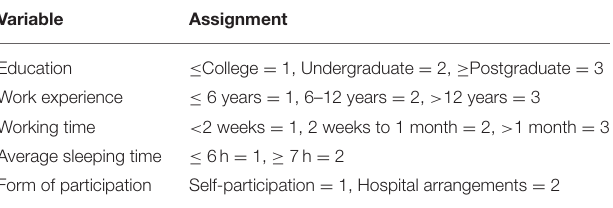
TABLE 4 | Variable assignment.